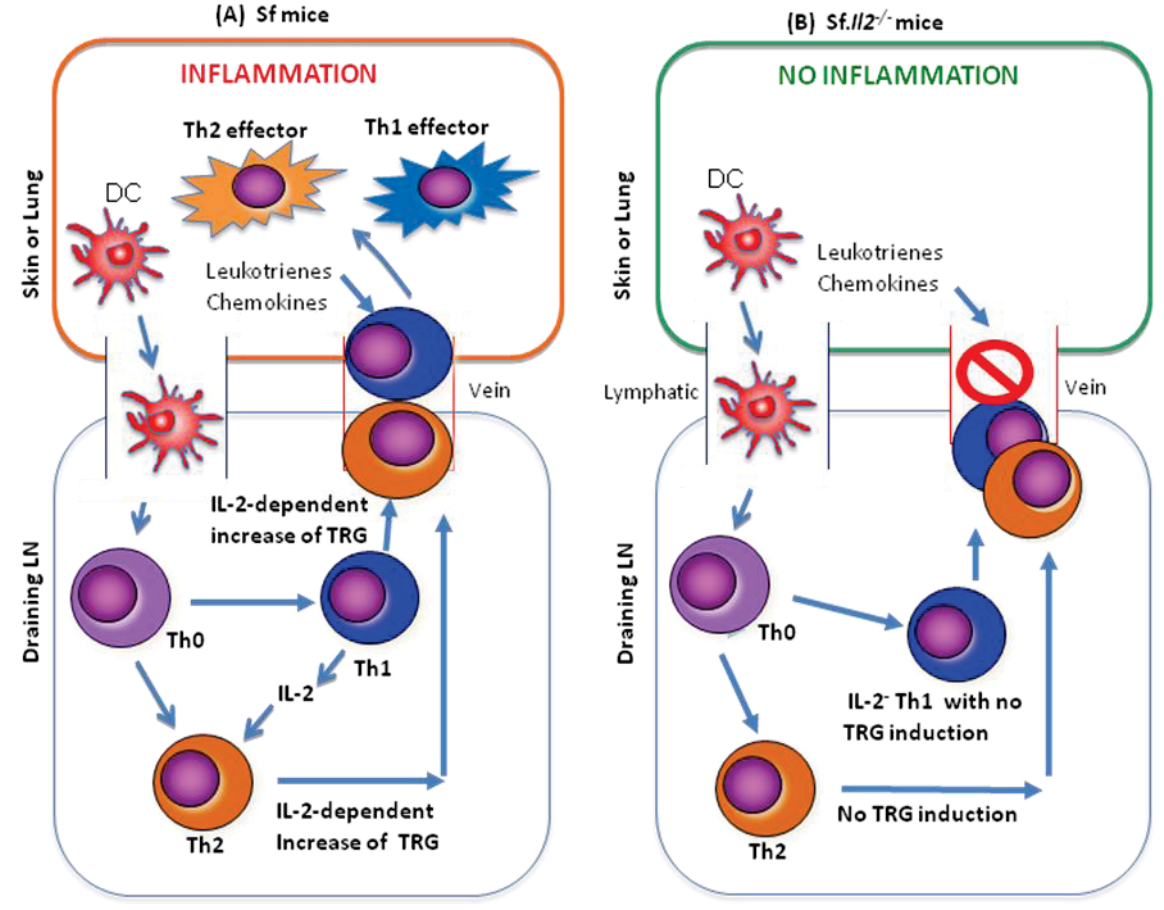
Figure 1. A schematic representation of how IL-2 controls the skin and lung inflammation in Sf mice. ( A ) In the Treg-deficient mice, tissue or environmental Ag are picked up and processed by the dendritic cells (DC), which go to the draining LN and are presented to the Th-cells that have specificity for the Ag. Without Treg and in the presence of IL-2, both Th1 and Th2 responses are expanded. TRG essential for Th cells to go to skin and lungs are induced in both subsets, which then travel to the skin and lungs to induce inflammation; ( B ) In the Sf. Il2 −/− mice, the processed Ag on DC failed to induce a Th2 response due to the absence of IL-2, which is required for Th2 expansion. More importantly, IL-2 is required for the induction of a panel of TRG required for the Th cells to travel to the skin and lungs. IL-2 is not required for the induction of TRG needed for liver inflammation and colitis; ( C ) In the Sf. Il4 −/− mice, the processed Ag on DC induce Th1 response and but the expression of IL-4-, IL-5-, and IL-13-Th2 cells are not expressed or are strongly inhibited. We do not know if they were activated by IL-2. However, the TRG required for skin and lung inflammation are induced in the Th cells by the presence of IL-2. These Th cells are capable of causing skin and lung inflammation; ( D ) In the Sf. Ifng −/− mice, the processed Ag on DC induced both IL-2-producing Th1 cells and IL-4-producing Th2 cells. Although lacking IFN- (cid:3) has a general effect (such as recruitment of leukocytes and enhancing Ag-presentation on inflammation), skin and lung inflammation eventually developed because the IL-2-controlled TRG are induced in the activated Th1 and Th2